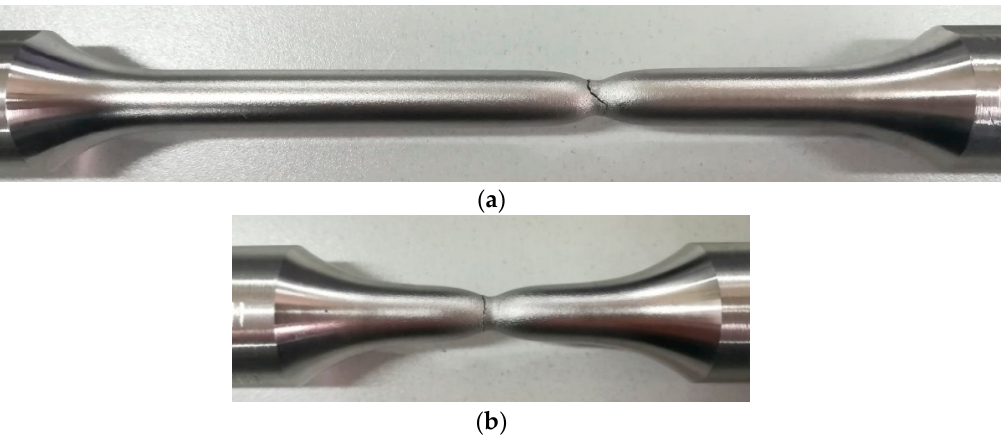
Figure 5. Tensile test failure morphology; ( a ) Conventional-gauge-length specimen; ( b ) Small-gauge- length specimen.